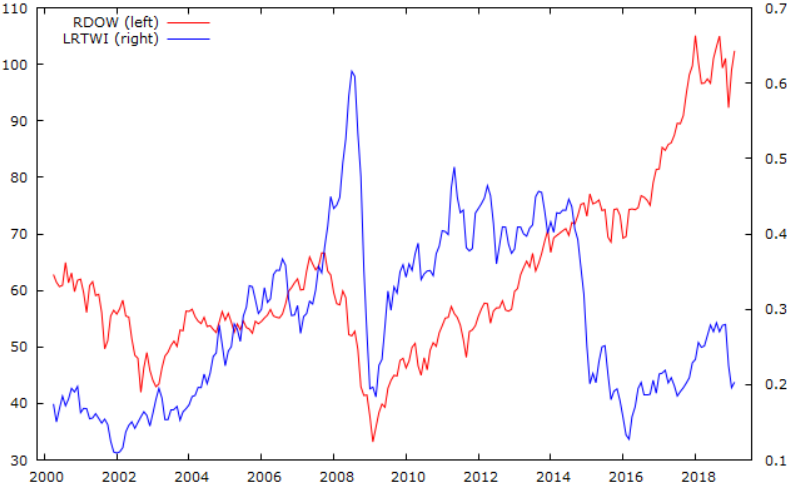
Figure 1. Plots of real values of Dow Jones Index and West Texas Intermediate (WTI) Crude Oil Index. Table 2. Augmented Dickey-Fuller (ADF) Tests. ADF Test with Constant ADF Test with Constant and Trend